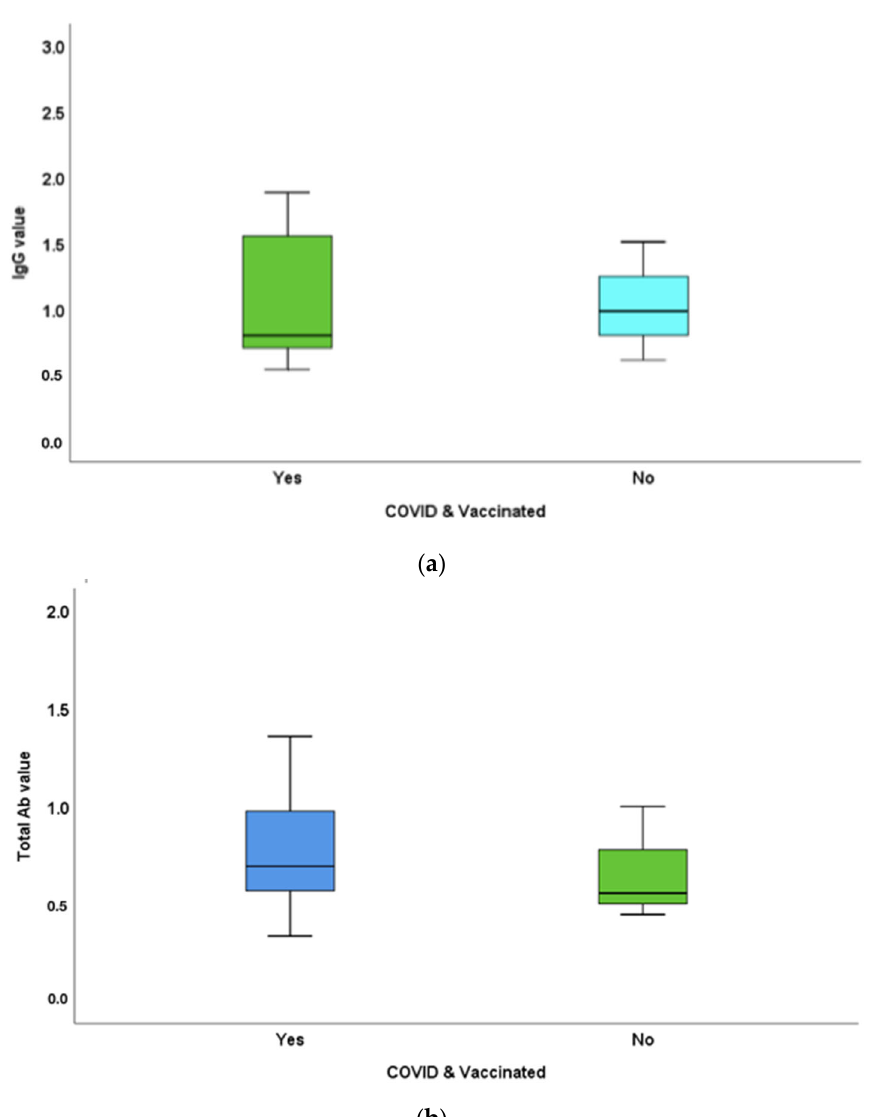
Figure 4. Differences between ( a ) mean IgG and ( b ) total antibody titres of study participants with a COVID-19 history with or without vaccination. ( a ) IgG in COVID-19-infected individuals with and without vaccination was 1.08 ± 0.49 and 1.03 ± 0.45 µ g, respectively. ( b ) Total antibody titres in the COVID-19-infected population with and without vaccination were 0.78 ± 0.32 and 0.67 ± 0.29 µ g, respectively. IgG and total antibody levels were in vaccinated individuals with COVID-19 history were greater compared to that of unvaccinated individuals with COVID-19 history. The IgG and total antibody titre differences in COVID-19 infected individuals with and without vaccination were not statistically significant ( p ‐ values = 0.81 and 0.48, respectively).